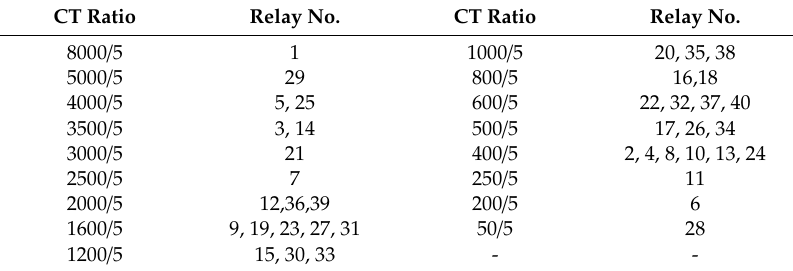
Figure 13. Diagram of the IEEE 14-bus system. Table 20. Current transfer ratio for the relay of the IEEE 14-bus